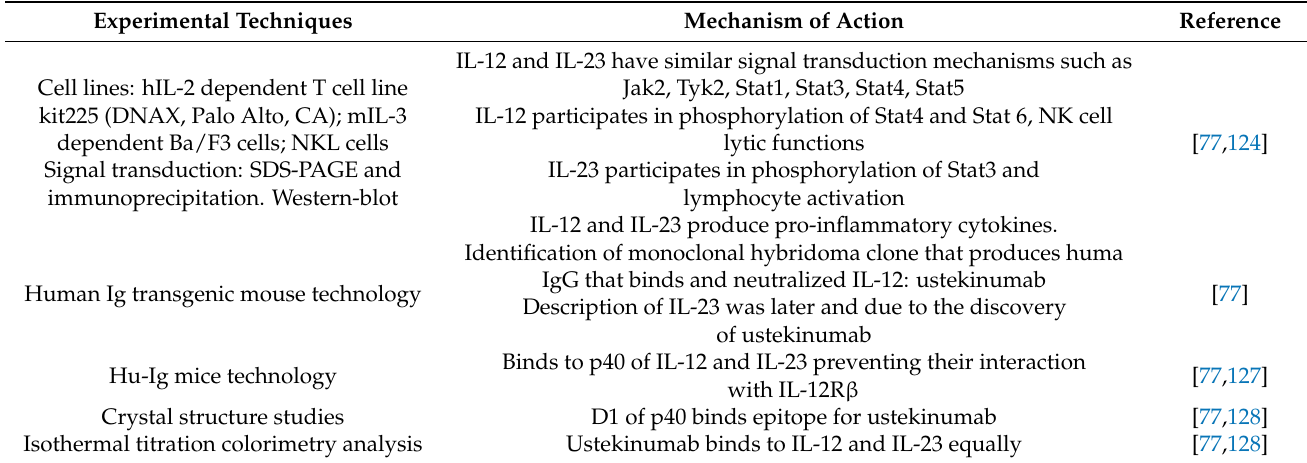
Table 5. Action mechanisms of ustekinumab and